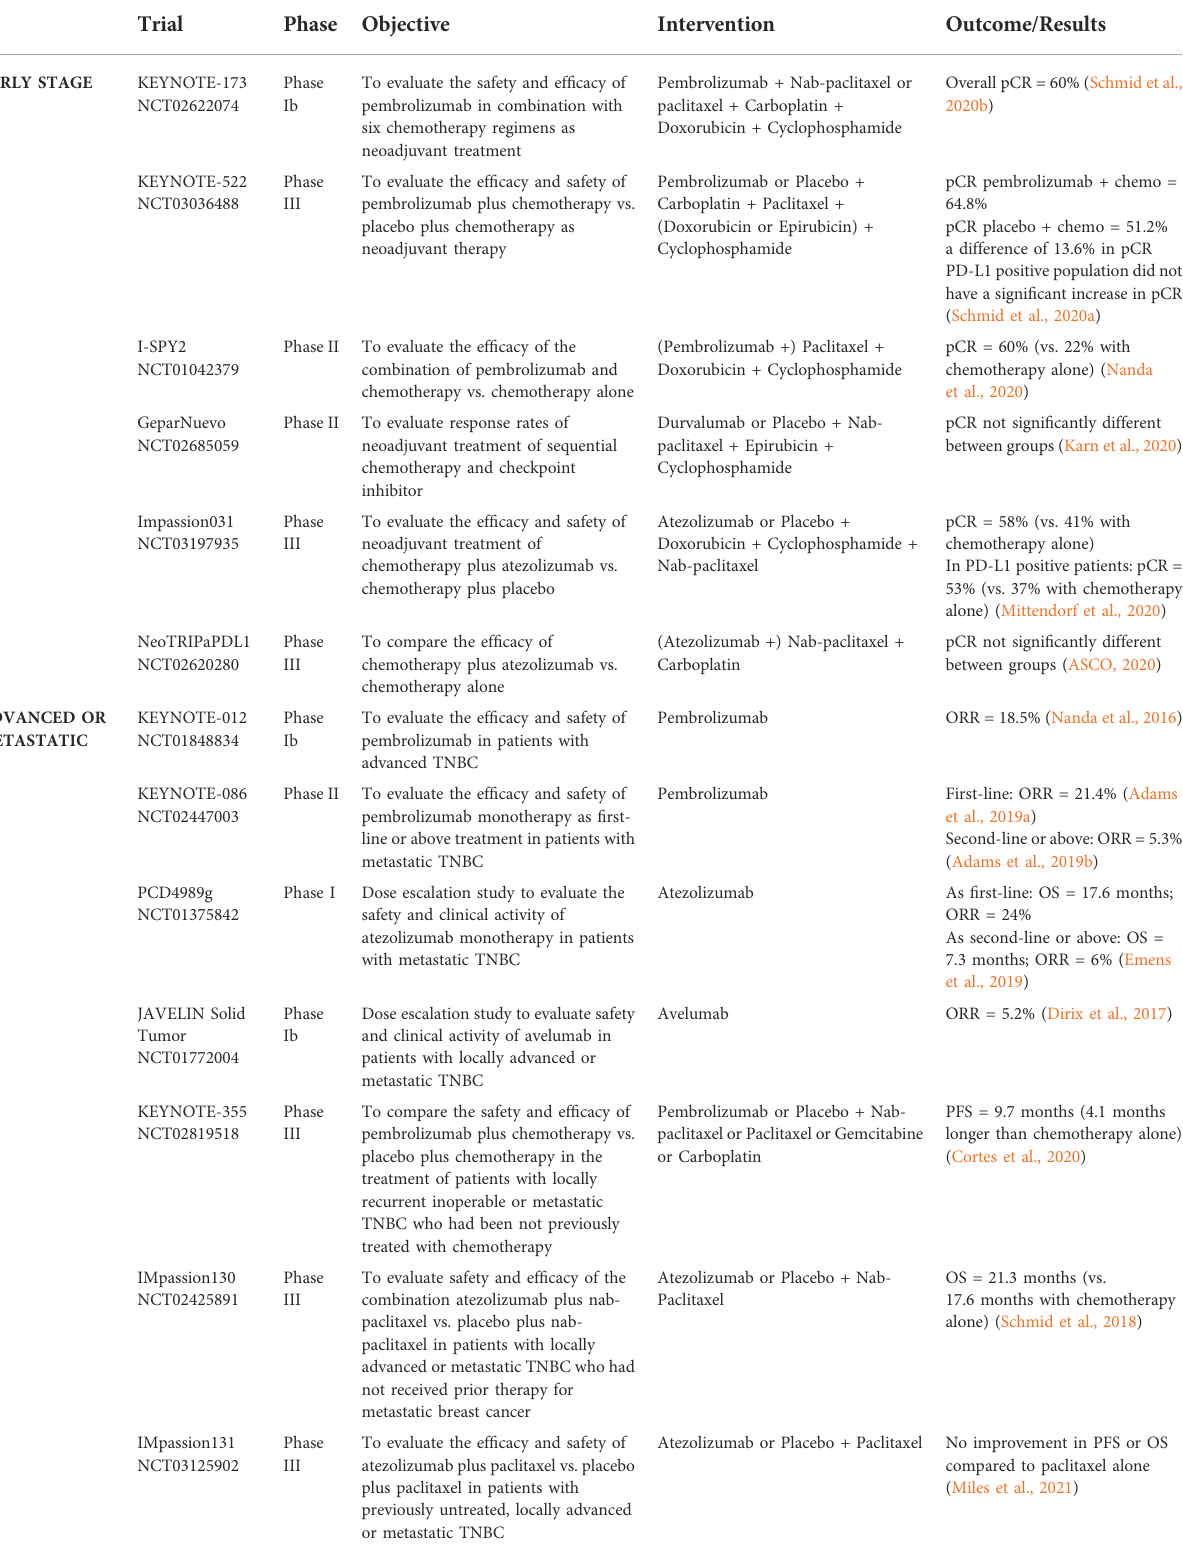
TABLE 2 Most relevant clinical trials for checkpoint inhibitors in TNBC, according to regimen and tumor